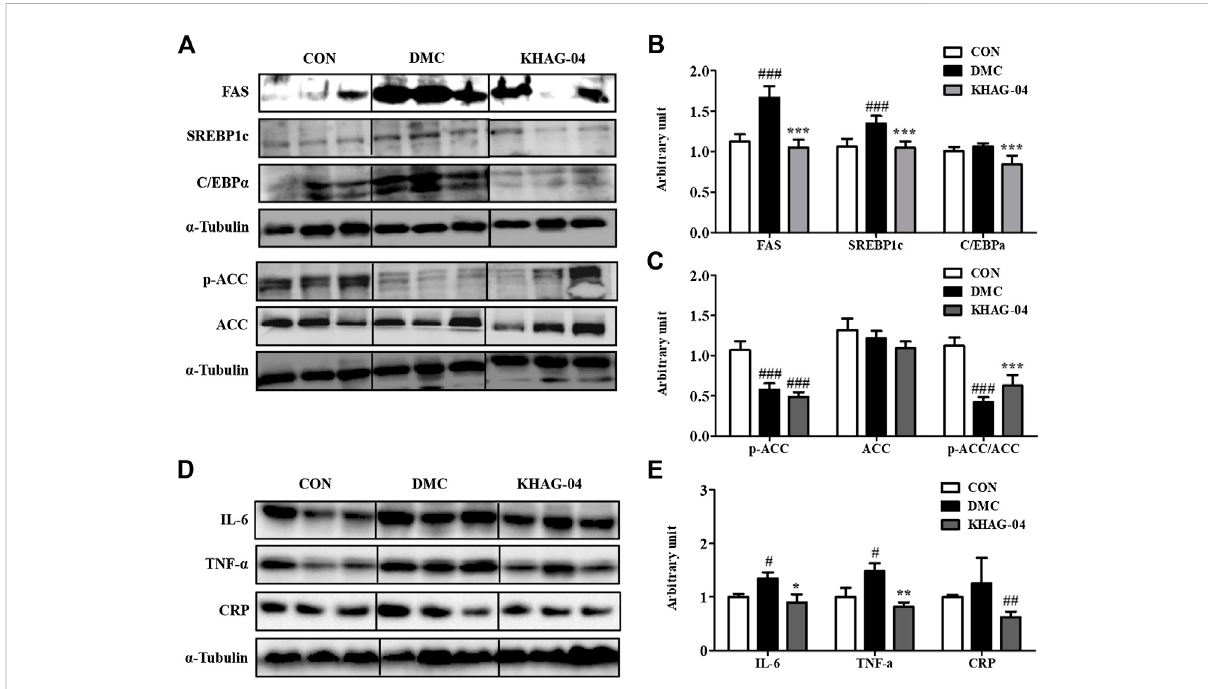
FIGURE 8 EffectsofKHAG-04onhepaticproteinlevelsoflipidmetabolism – relatedandin fl ammation-relatedmarkers. (A) Proteinexpressionoffattyacid synthase (FAS), sterol regulatory element – binding protein1 (SREBP1c), CAAT box/enhancer – binding protein alpha (C/EBP α ), and phospho acetyl- CoA carboxylase (p/T-ACC) in liver tissue of T2DM mice. The hepatic protein was measured by Western blot. The bands show the intensity of the bands that were densitometrically measured and normalized to the band levels of α -tubulin (B,C) . (D) Representative band images indicate the proteinexpressionofNAFLDandpro-in fl ammatorycytokines – relatedantibodies(CRP,IL6,andTNF- α )asmeasuredbyWesternblotting. (E) Relative band intensities of CRP, IL-6, and TNF- α . All data are indicated as mean ± SEM ( # p < 0.05, ## p < 0.01, ### p < 0.001 vs Control; * p < 0.05, ** p < 0.01, *** p < 0.001 vs 60% kcal high-fat diet + 60 mg/kg streptozotocin;